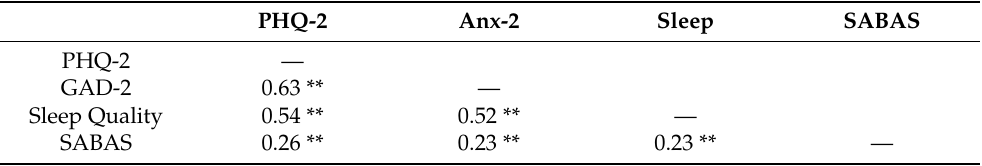
Table 7. Spearman’s correlations testing concurrent validity between the Smartphone Application- Based Addiction Scale and other